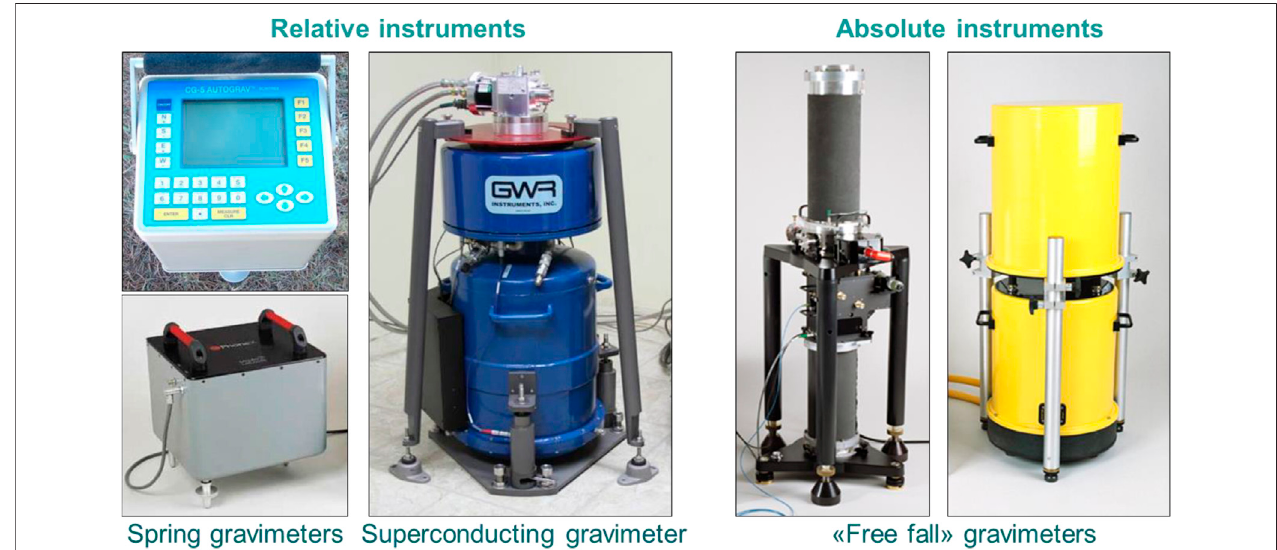
FIGURE 1 | Some land gravimeters currently available on the market. On the left, relative gravimeters of the spring and superconducting type. On the right, free fall absolute gravimeters.